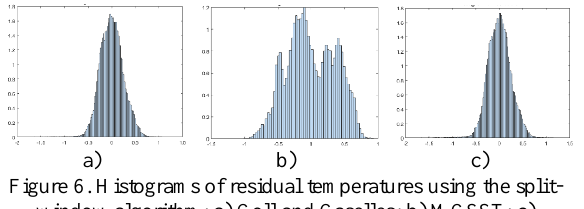
Figure 6. Histograms of residual temperatures using the split- window algorithm; a) Coll and Caselles; b) MCSST; c) NLSST